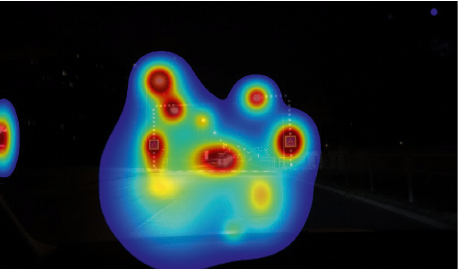
Figure 12b. 3M VAS heatmap analysis; Halogen